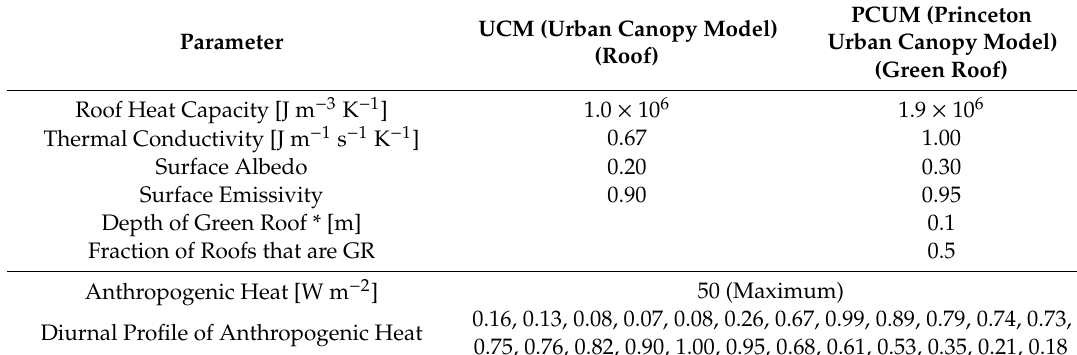
Table 1. Parameters used in the simulations [38]. *Green roofs (GRs) are 0.1 m